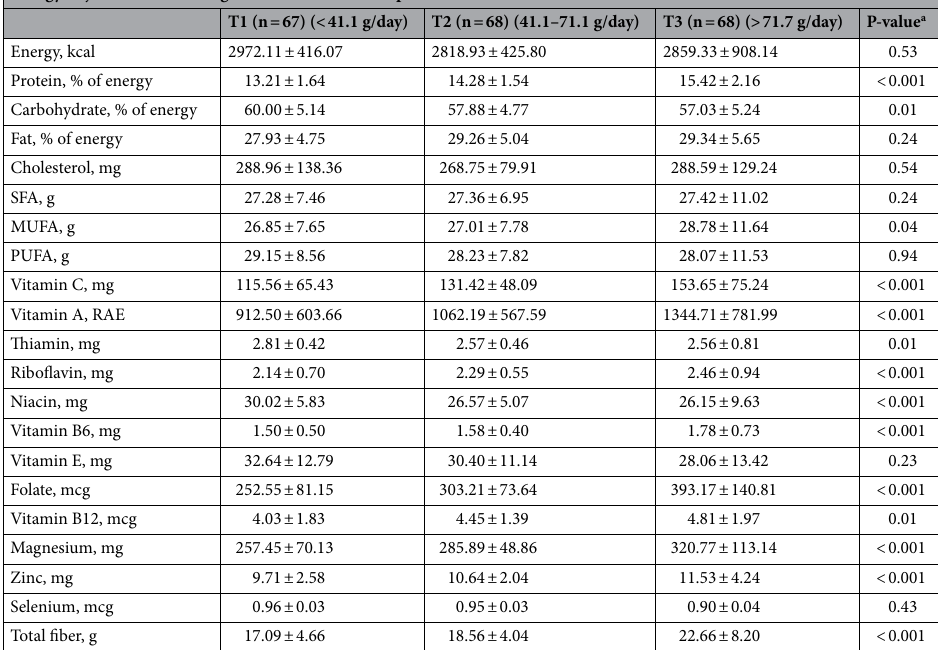
Table 2. Dietary intakes (energy and macro/micro nutrients) of study participants across energy-adjusted tertiles of legumes and nuts consumption. Values are mean ± SD. Energy intake and macronutrients were adjusted for age and gender; all other values were adjusted for age, gender and energy intake. SFA saturated fatty acids, MUFA monounsaturated fatty acids, PUFA polyunsaturated fatty acids. a P-value obtained from ANCOVA test for adjustment of energy intake.